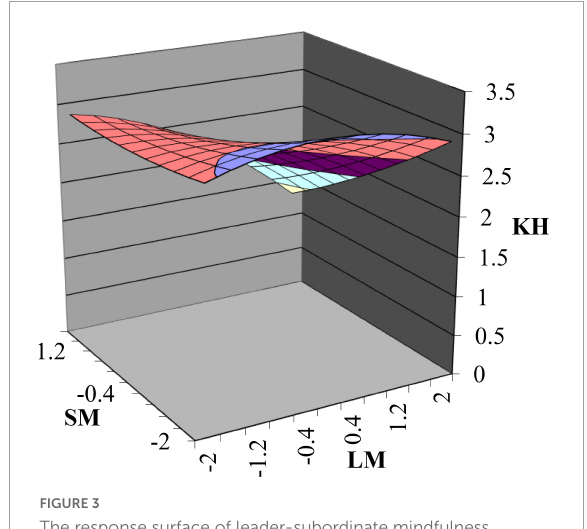
FIGURE3 The response surface of leader-subordinate mindfulness congruence and knowledge